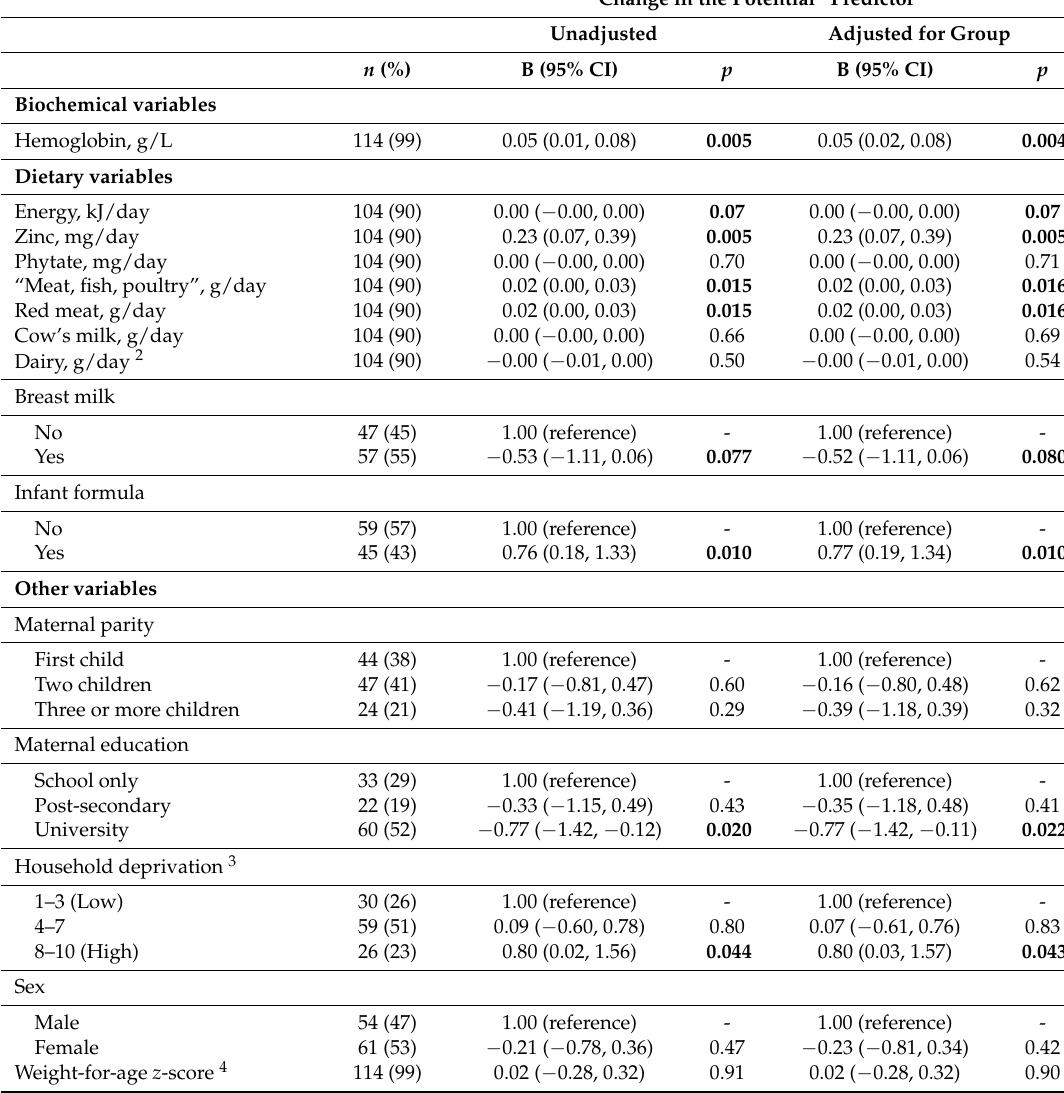
Table 3. Univariate associations between potential “predictor” variables and plasma zinc concentration ( µ mol/L) at 12 months of age. Change in Plasma Zinc Concentration ( µ mol/L) 1 for Each Unit Change in the Potential “Predictor” Unadjusted Adjusted for Group n (%) B (95%